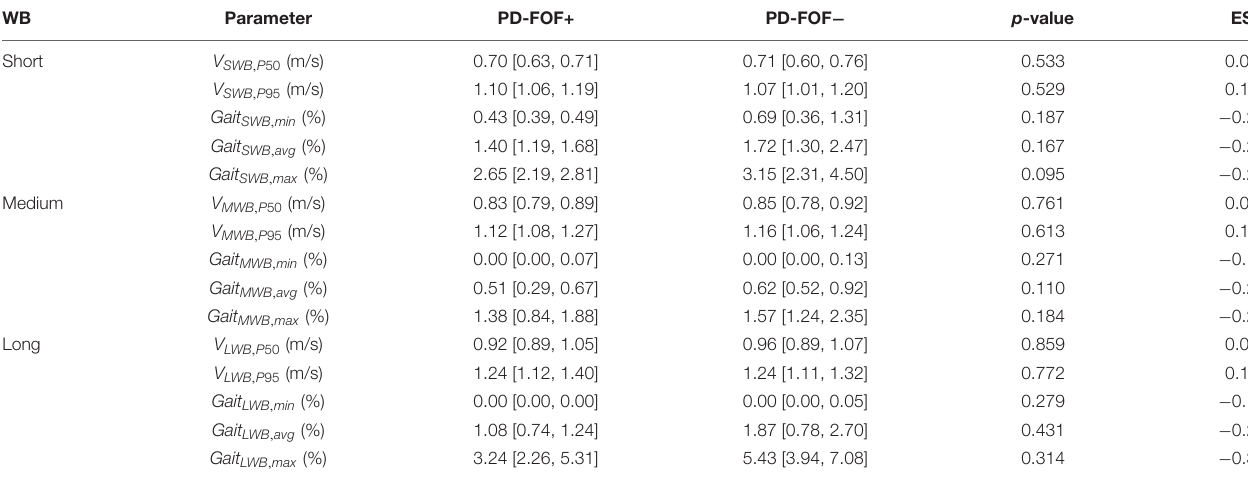
TABLE 3 | Comparison of the extracted parameter for short, medium, and long walking bouts (WB) between PD-FOF+ and PD-FOF −